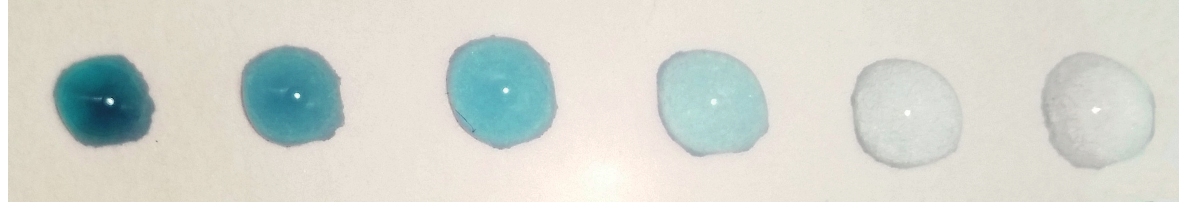
Figure 3. An example based on calibration using two-fold serial dilutions of plasma. Undiluted plasma is the left drop; the right drop is 32 times diluted plasma. The photograph was taken in the dark (in a black distance tube) using the smartphone chosen for the experiments and integrated LED flash as a sole source of